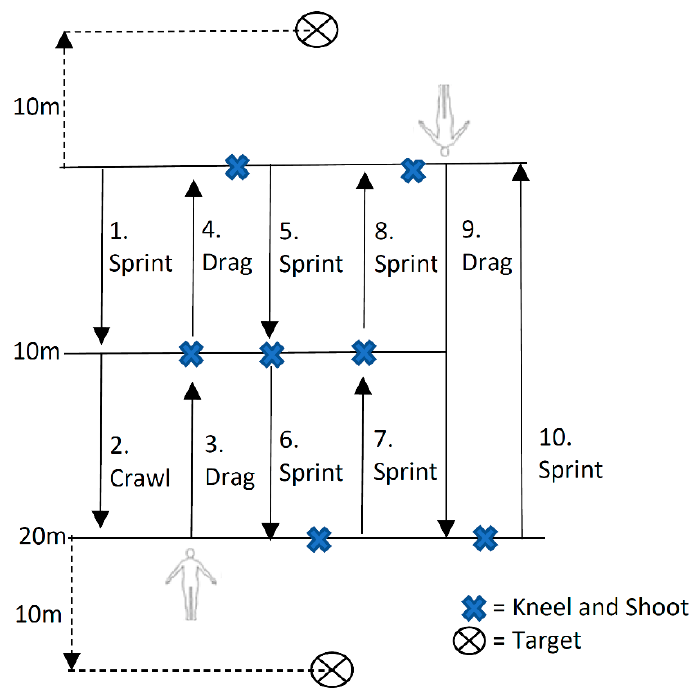
Figure 1. Occupational-specific physical assessment (OSPA) course layout and conduct.